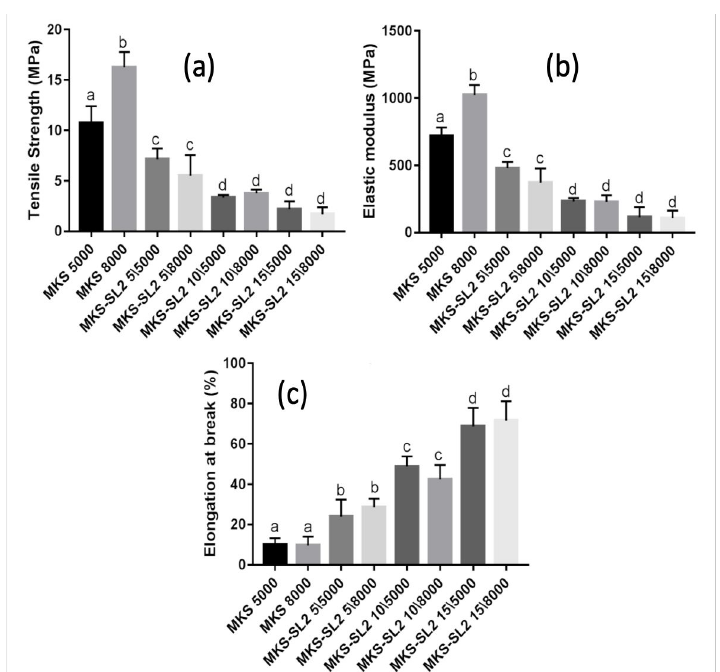
Figure 5. XRD patterns of the different film’s formulations.